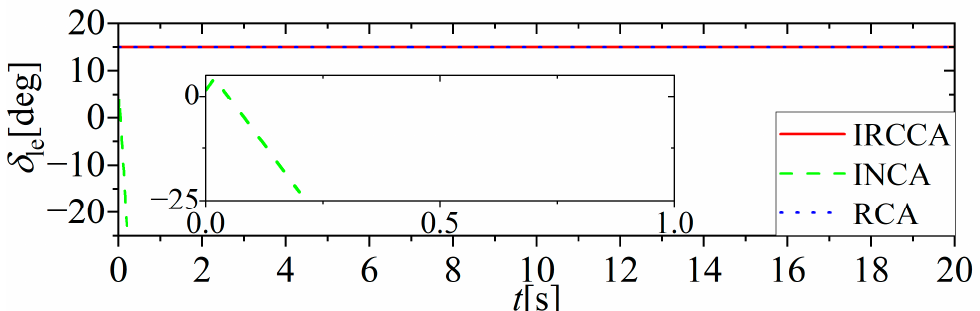
δ deflection. le